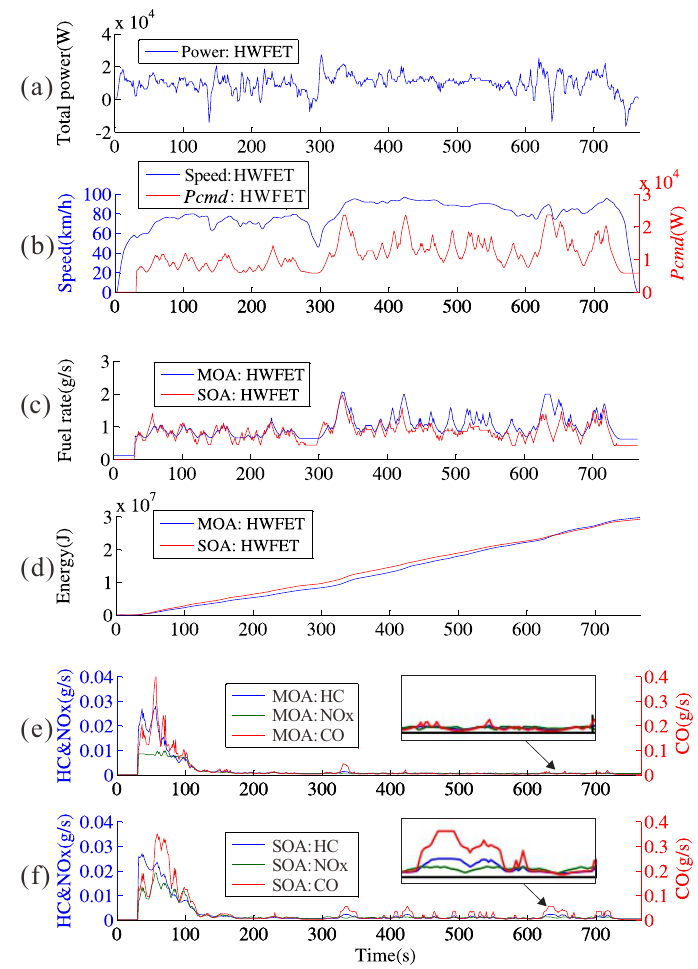
Figure 11. Required total power, speed, power, fuel rate, cumulative energy consumption and emissions of the high way fuel economy test (HWFET) driving cycle. ( a ) total power; ( b ) speed and power; ( c ) fuel rate; ( d ) cumulative energy consumption; ( e ) emissions from MOA; and ( f ) emissions from SOA.